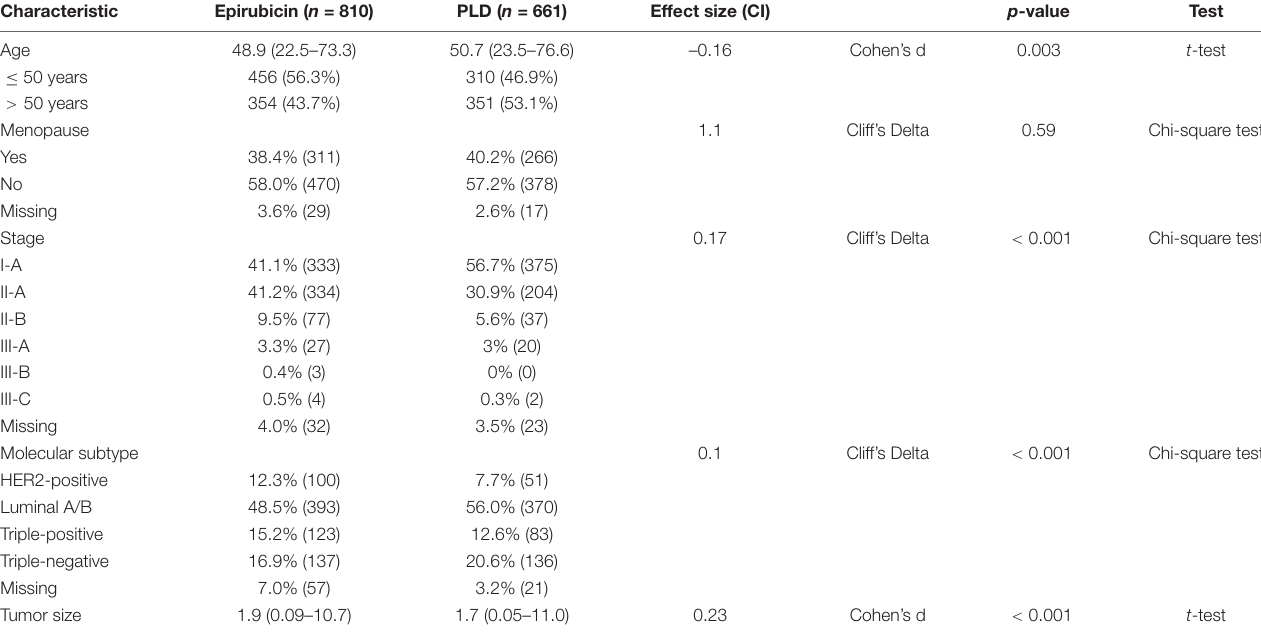
TABLE 1 | Clinical and pathological characteristics of breast cancer patients treated with PLD or epirubicin-based regimens.